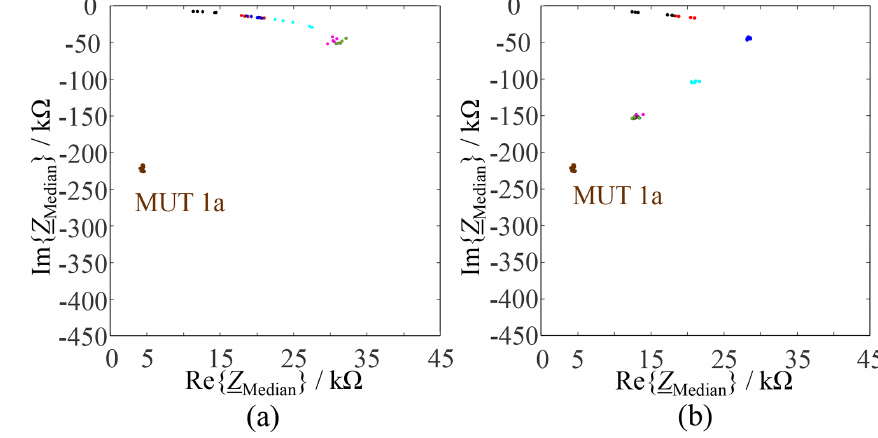
Figure 10. “Median” feature measured in the field. (a) Batch 1. (b) Batch 2.